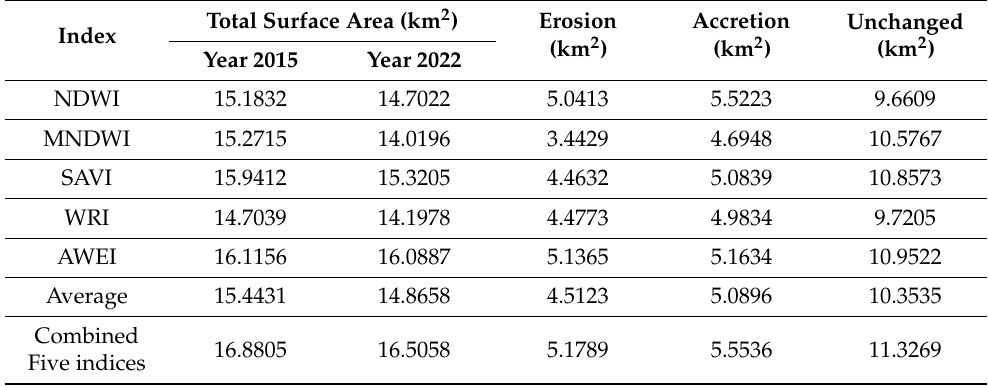
Table 5. Surface water area and riverbank erosion and accretion areas obtained from each water